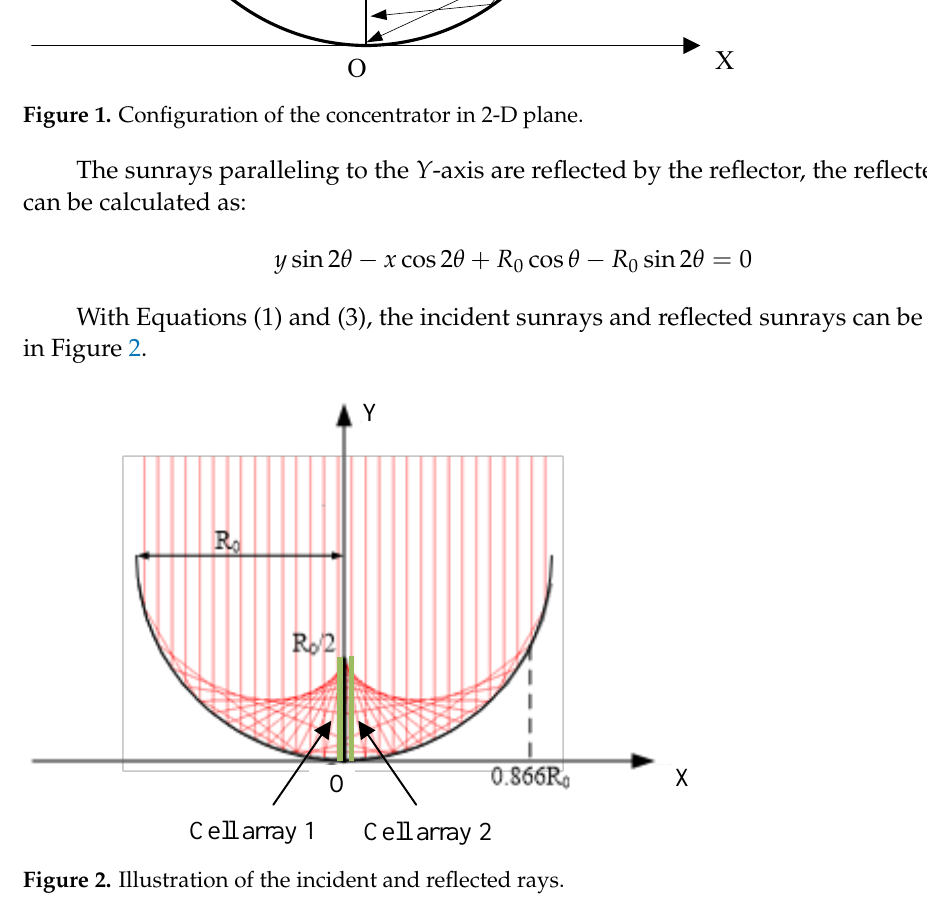
Figure 2. Illustration of the incident and reflected rays.